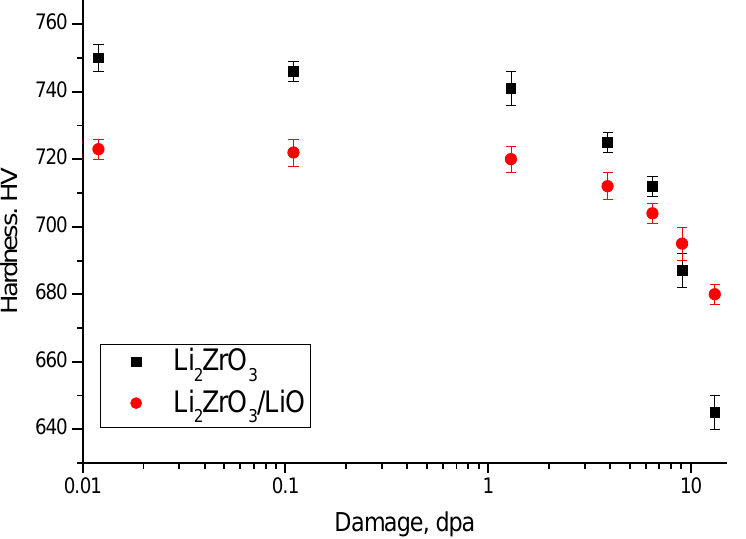
Figure 7. Results of changes in the microhardness of ceramics depending on the value of atomic displacements (displacement values are presented on a logarithmic scale).